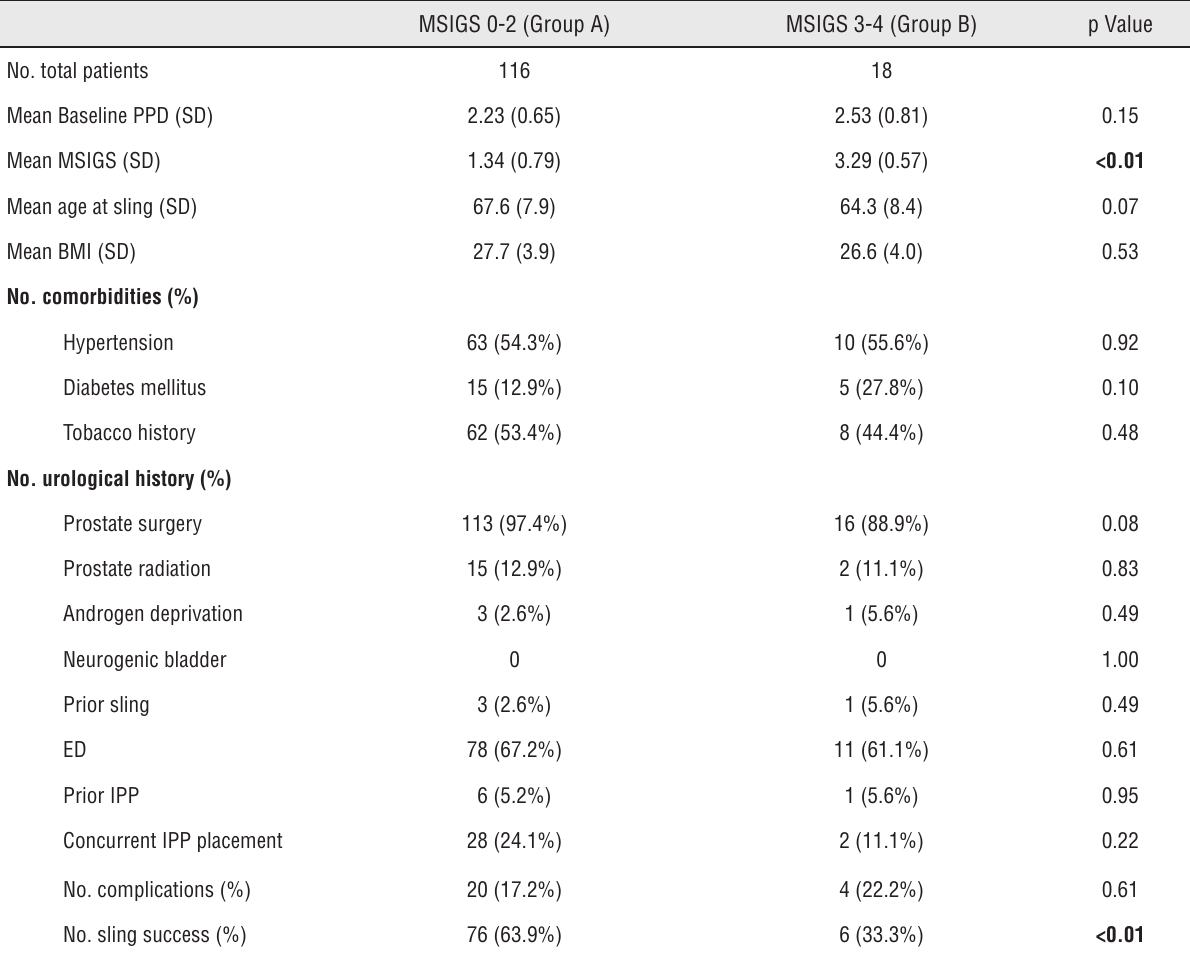
Table 1 - Preoperative demographics and clinical history and postoperative outcomes among men with reported moderate SUI (2-3 PPD), stratified by favorable (MSIGS 0-2) and unfavorable (MSIGS 3-4).